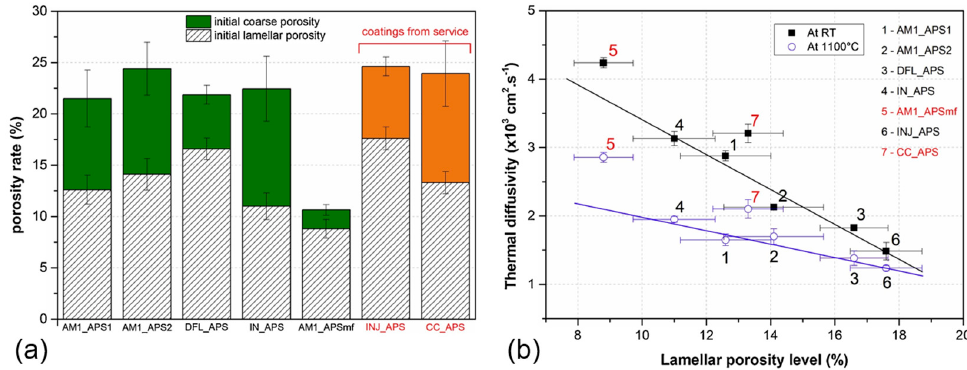
Figure 12. SEM micrographs of cross-sections of TBCs with different parameters: ( a ) AM1-APS 1: Haynes 188 + 40 μ m NiCrAlY + 110 μ m YSZ, ( b ) AM1-APS 2: Haynes 188 + 15 μ m NiCrAlY + 430 are the corresponding higher magnifications of the ceramic coatings [92] .